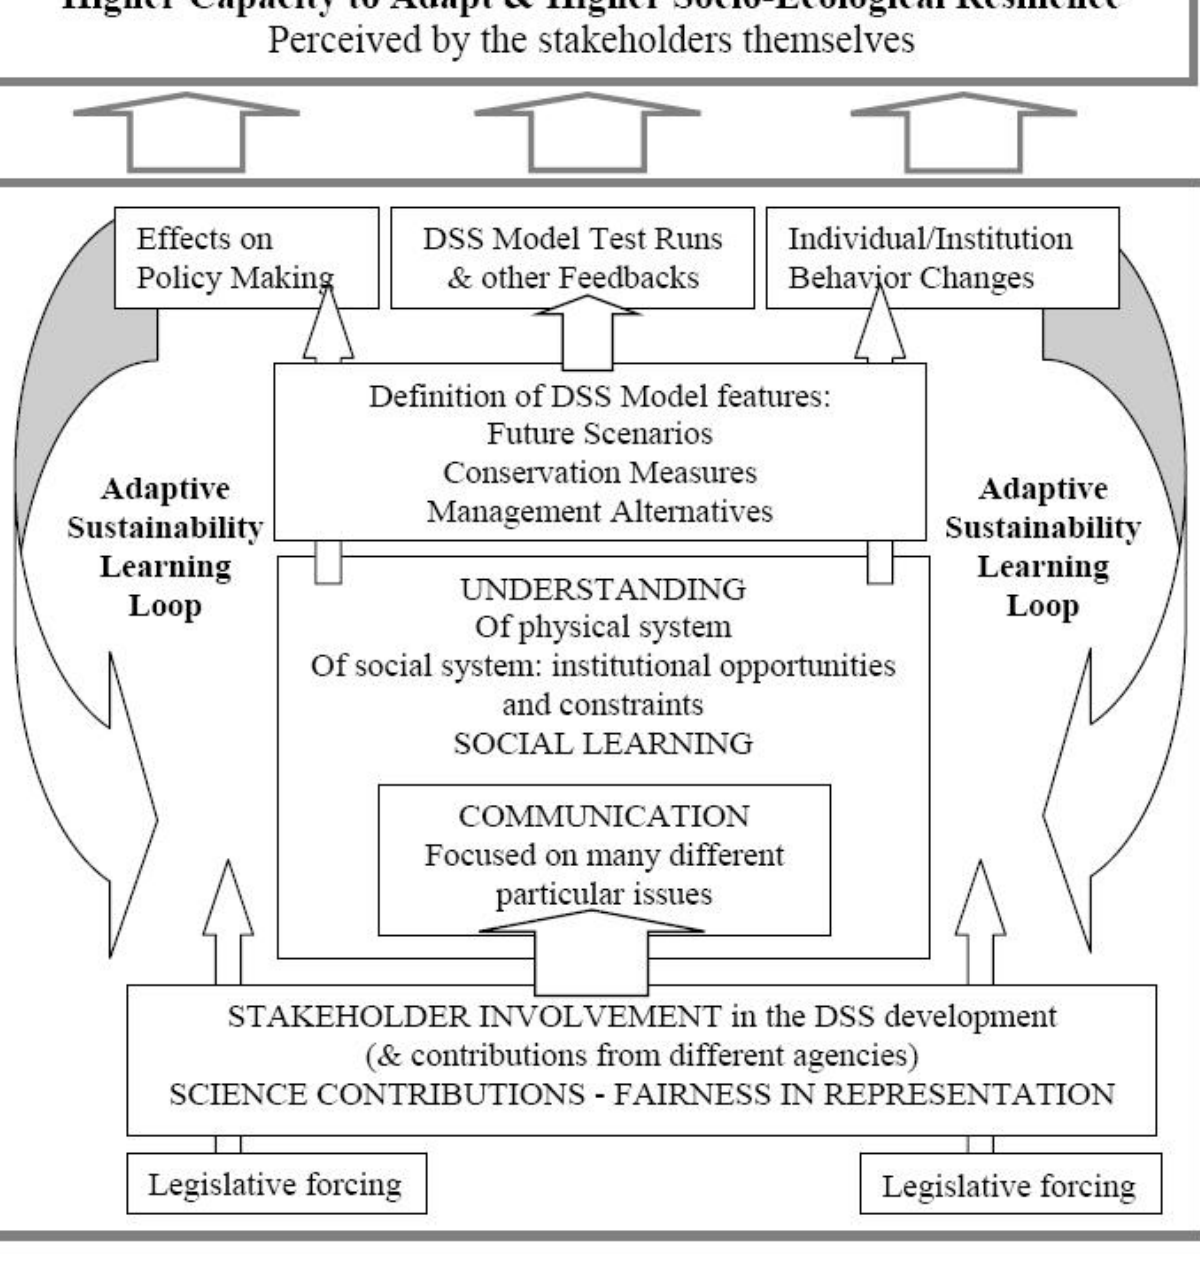
Figure 1. The authors’ conceptual representation of the DSS development process in the San Pedro Basin, illustrating the key mechanisms contributing to resilience in the basin’s social–ecological